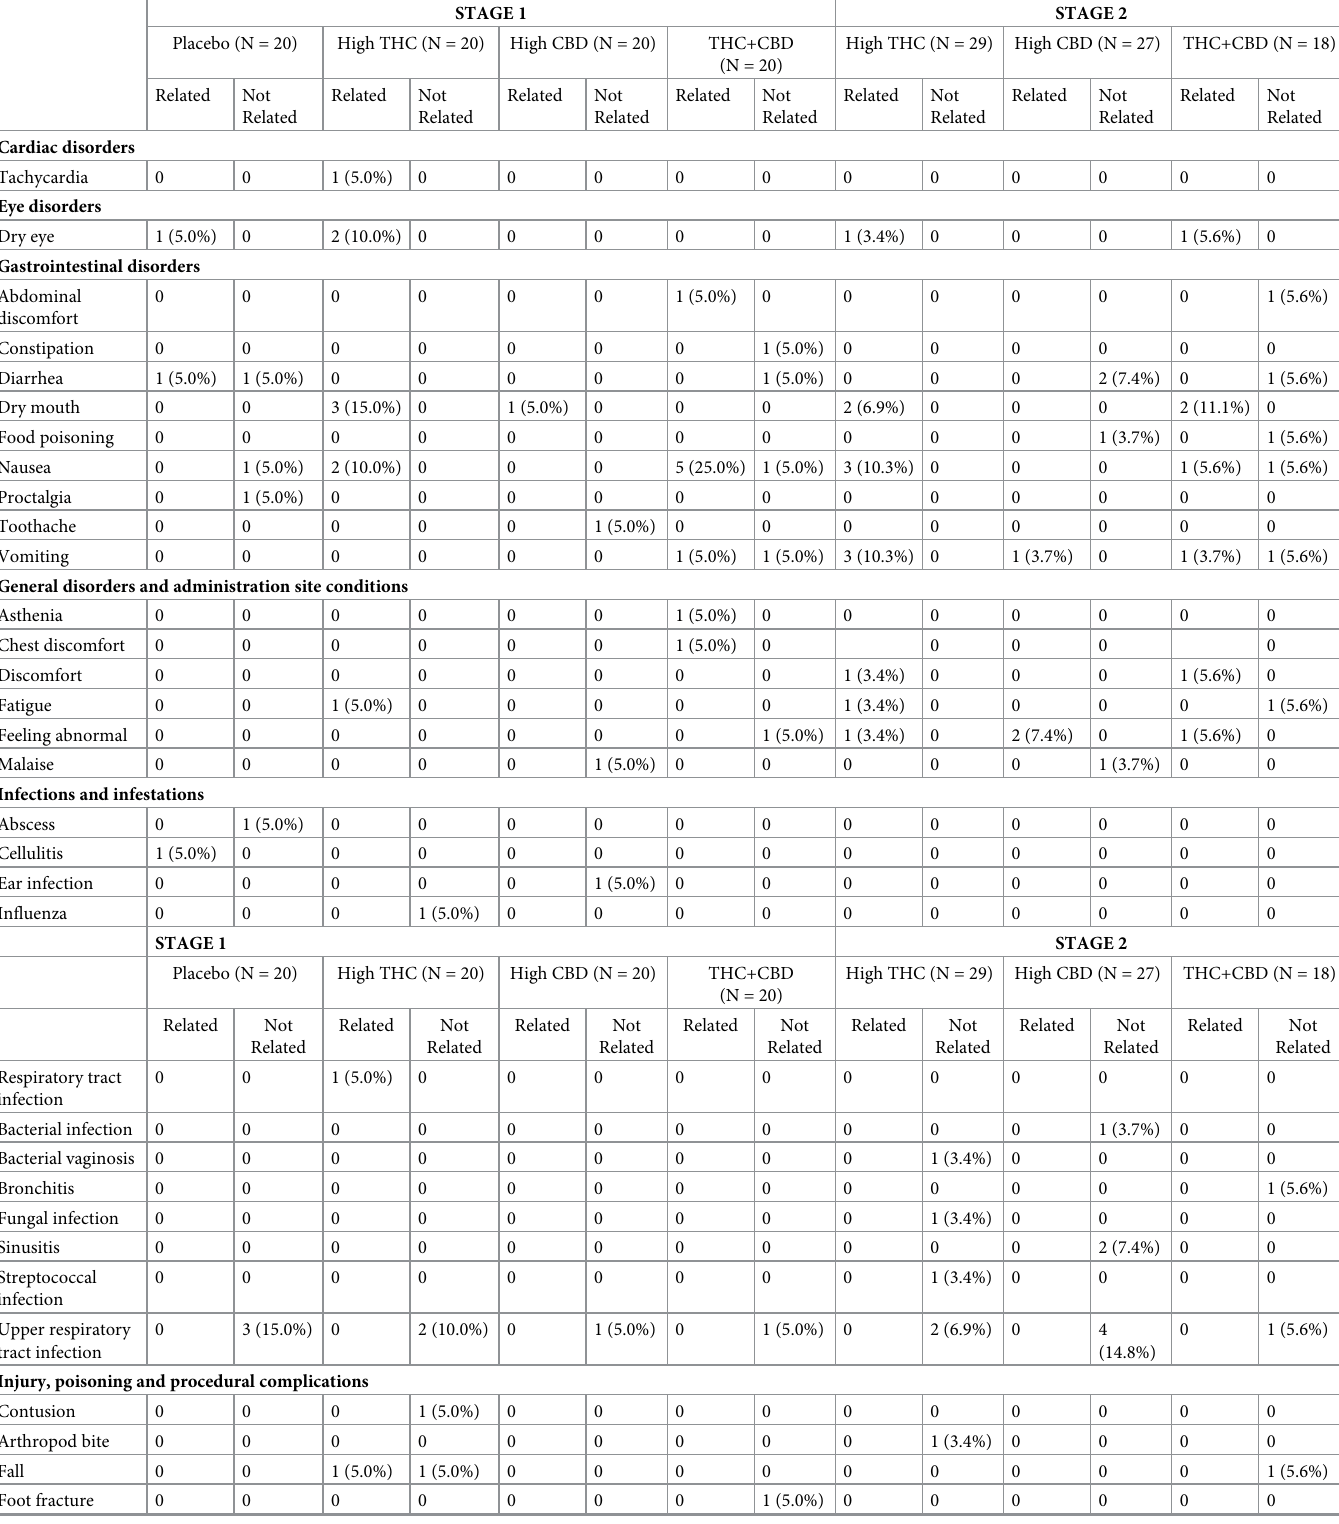
Table 3. Number of participants with adverse events by systems organ class/preferred terms and